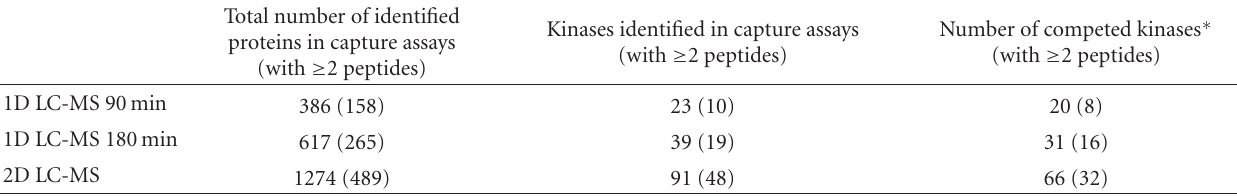
Table 1: Proteins and kinases identified in the di ff erent LC-MS